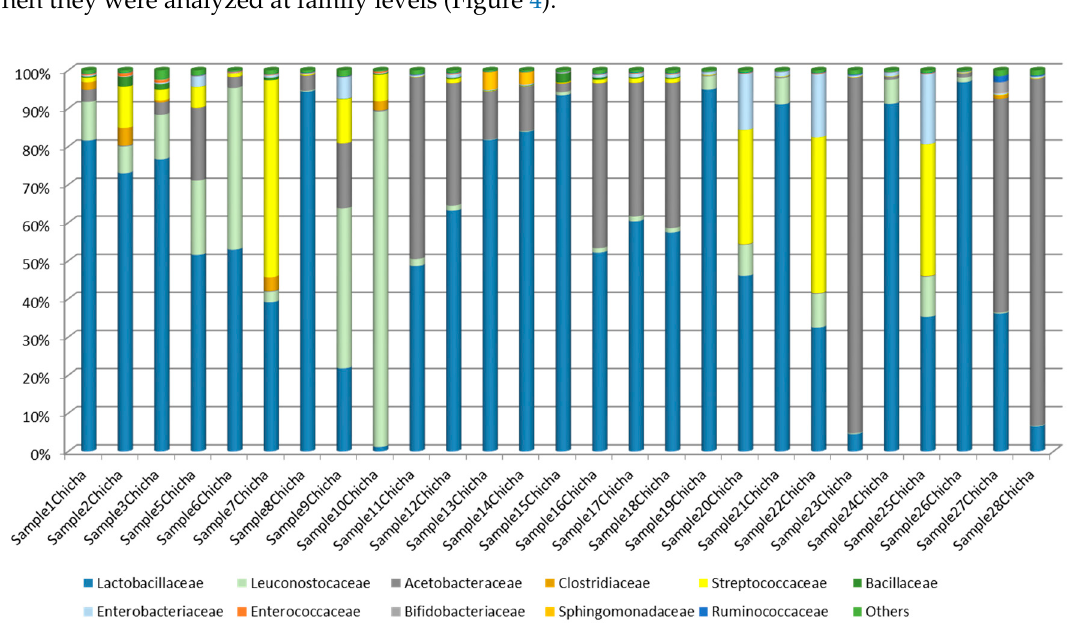
Figure 4. Bacterial community composition at family level of the 27 chicha samples.